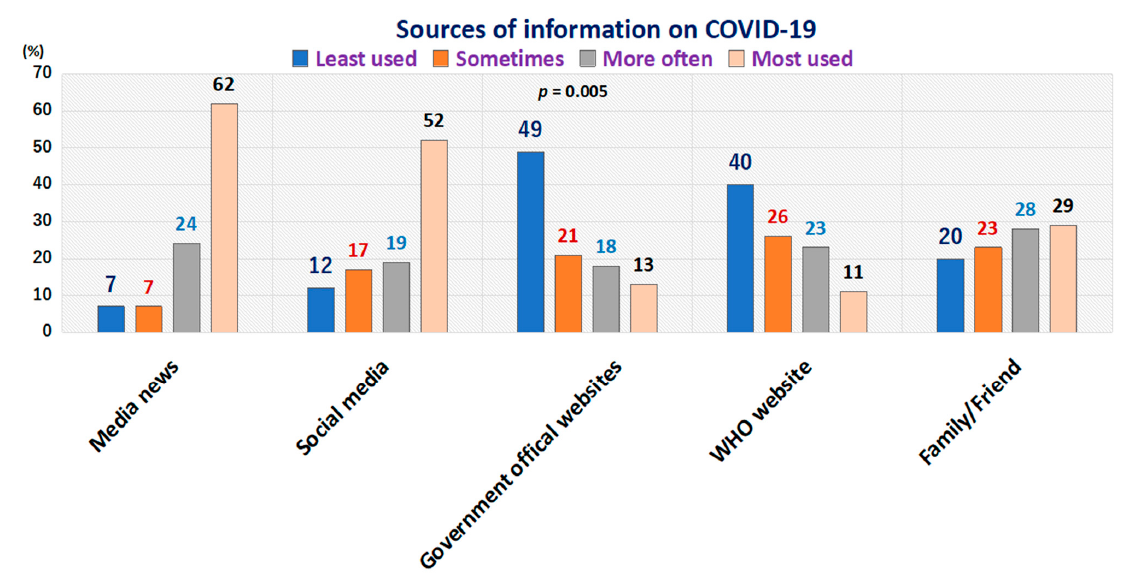
Figure 2. Distribution of respondents (%) according to the frequency of use of sources of information on COVID-19.